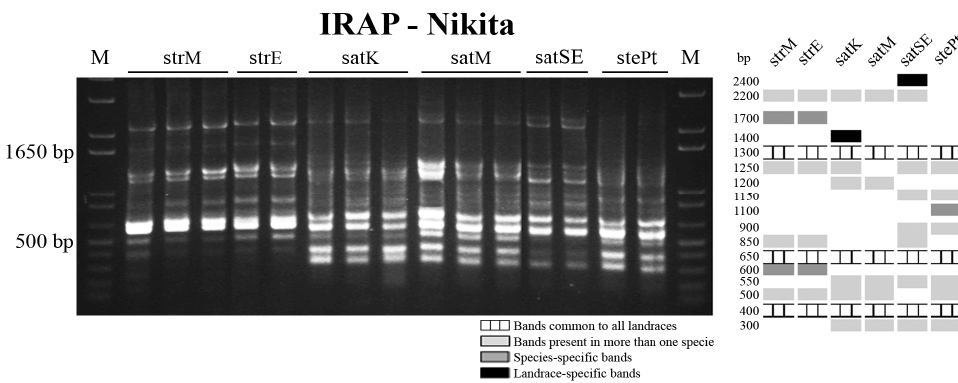
Figure 6. Inter-retrotransposon amplified polymorphism (IRAP) banding profiles obtained with primer for Nikita retrotransposon long terminal repeat (LTR) and correspondent schematic representation. M: molecular marker 1 Kb+; strM— A. strigosa from Madeira Island; strE— A. strigosa from Elvas; satK— A. sativa “Kyto”; satM— A. sativa from Madeira Island; satSE— A. sativa “S. Eulália”; stePt— A. sterilis Pt.